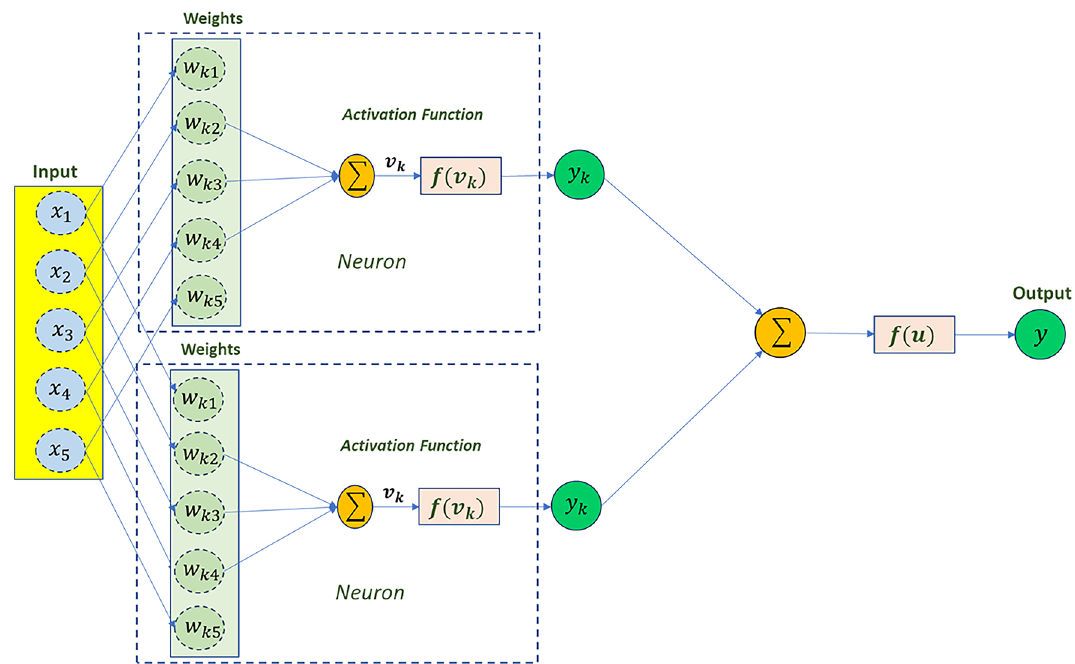
Fig. 9 Neural network typical